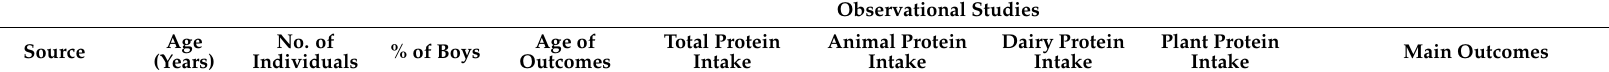
Table 3. Characteristics of 14 studies describing long-term effects of protein intake in healthy children and